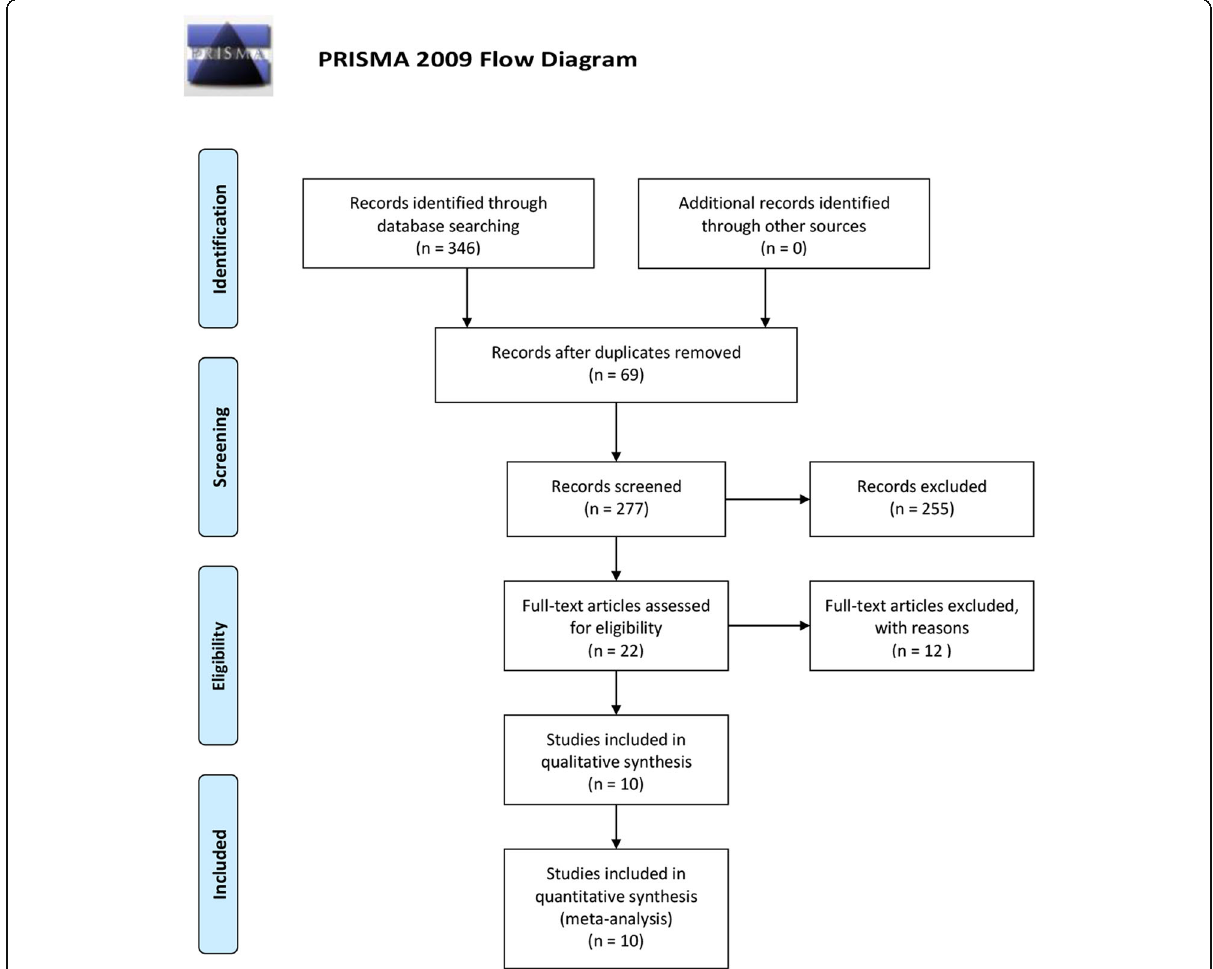
Fig. 1 Search strategy and flow chart of the screened, excluded, and analysed